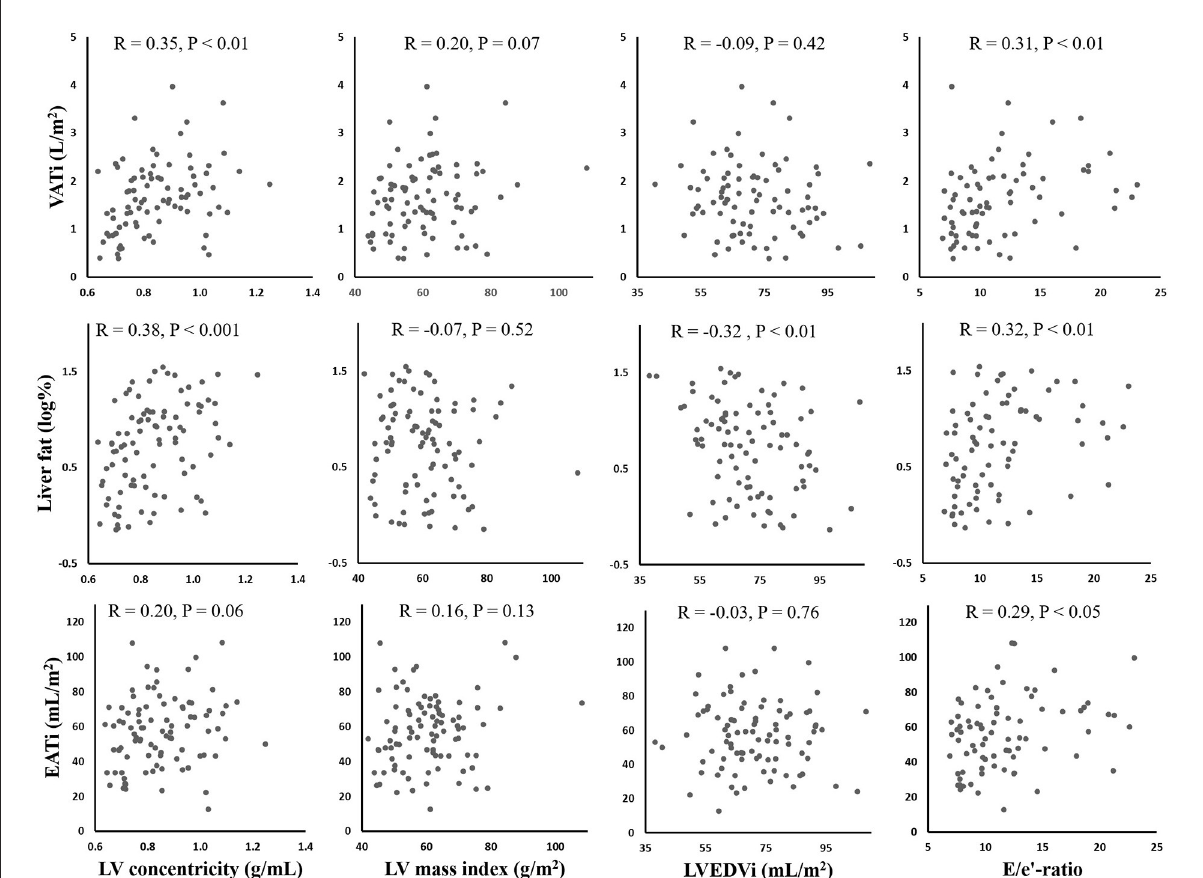
FIGURE2 Scatterplots showing the correlations between fat depots (Y-axes) and left ventricular parameters (X-axes). Pearson’s correlation coefficients (R) and P-values are provided for each plot. VATi, visceral adipose tissue index; EATi, epicardial adipose tissue index; LV, left ventricular; EDVi, end-diastolic volume index; E, early diastolic velocity of mitral inflow; e’, early diastolic mitral annular